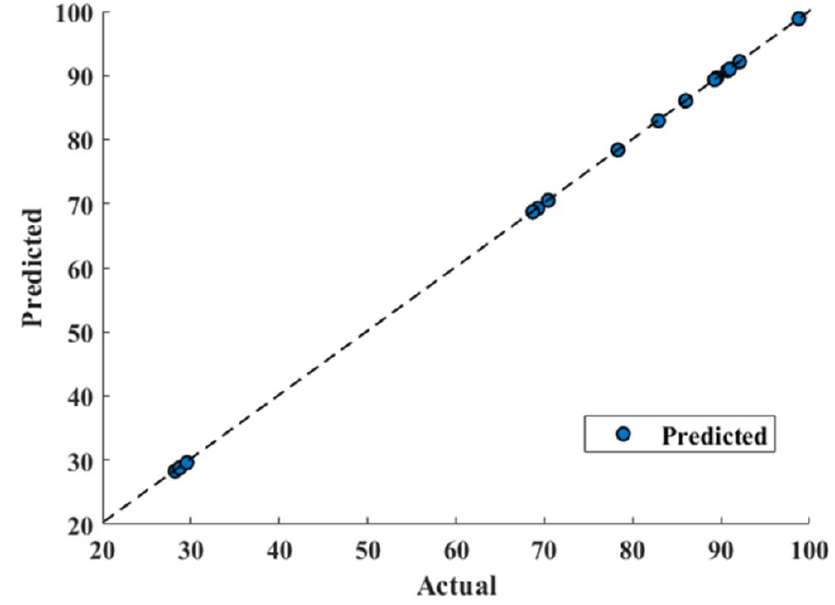
Figure 9. Response surface methodology model performance prediction (actual versus predicted).